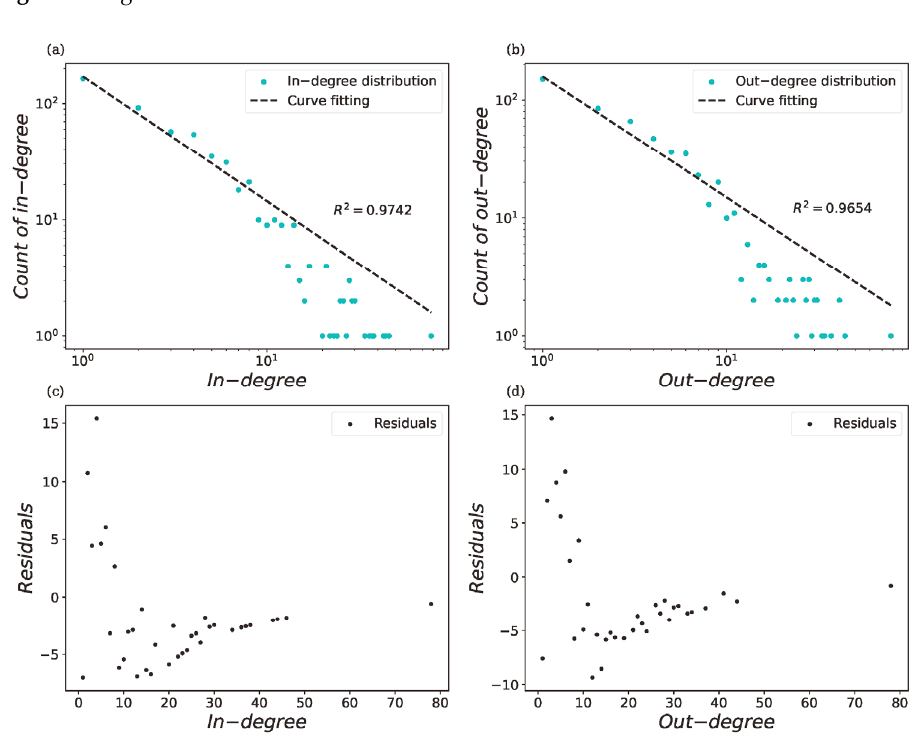
Figure 4. In-degree and out-degree power-law curve fitting. ( a , b ) illustrated the power-law curve fitting results for in-degree and out-degree of GLSN respectively. ( c , d ), illustrated their fitting re- siduals.